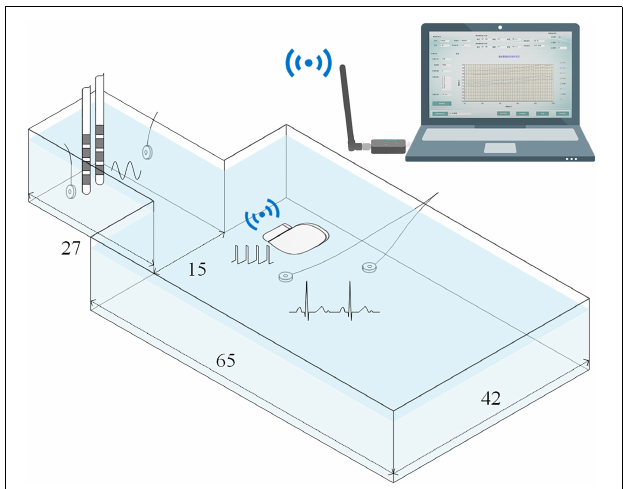
FIGURE 3 | Illustration of the simulated recording setup. The titanium case and the DBS electrodes were fully immersed in the phantom that was filled with saline solution.Phantom size is expressed in centimeters. A 23Hz sinusoidal signal and a standard ECG waveform were delivered by two pairs of Ag/Cl disc-electrodes. The recordings were wirelessly transmitted toa